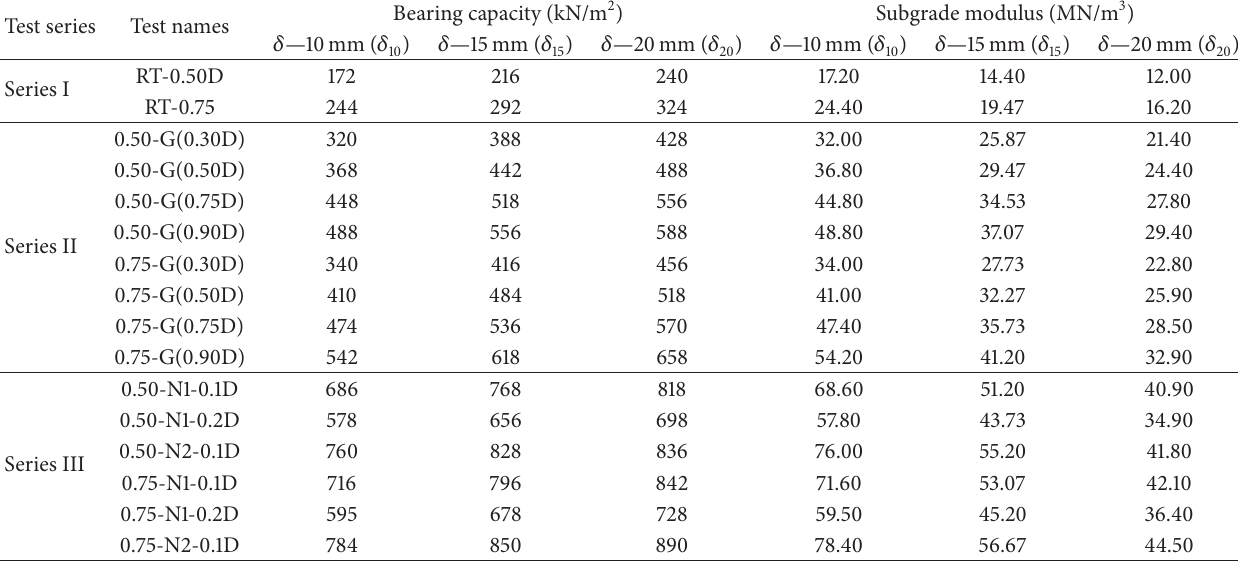
Table 2: Bearing capacity and subgrade modulus for Series I, II, and